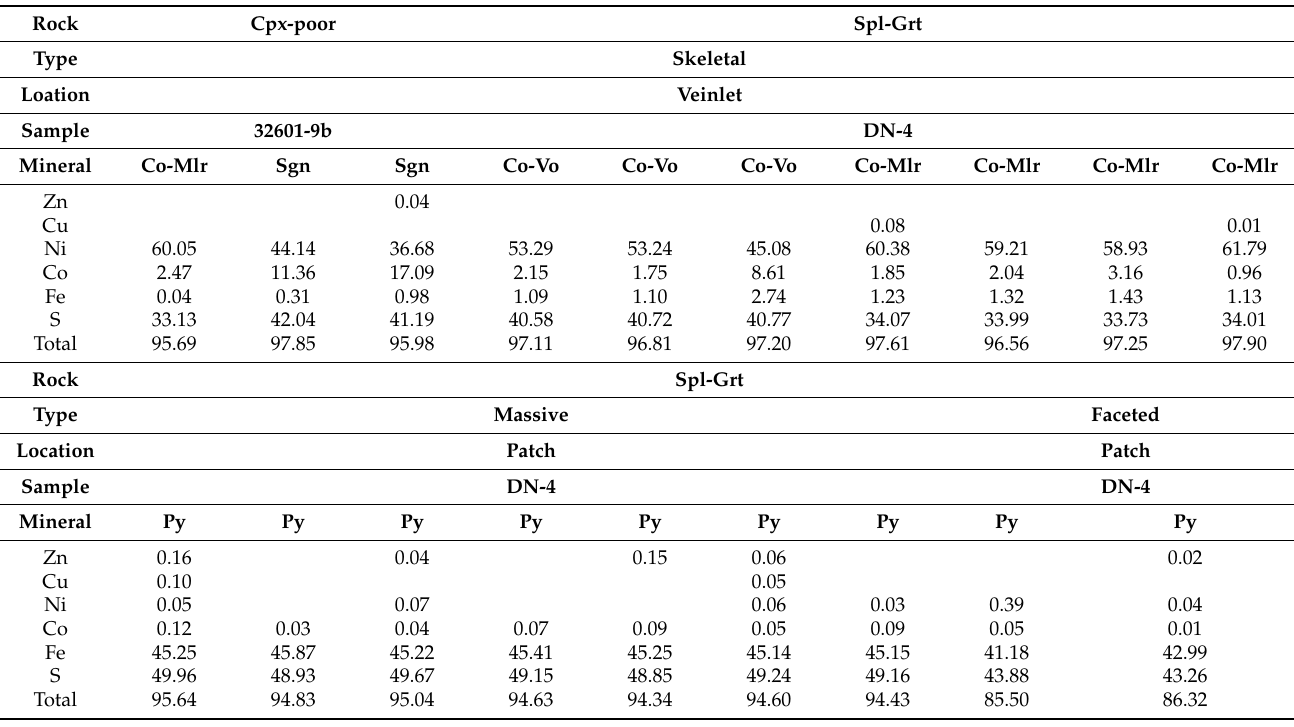
Table 4. SEM analyses of m-type sulfides in lherzolites from East Antarctica